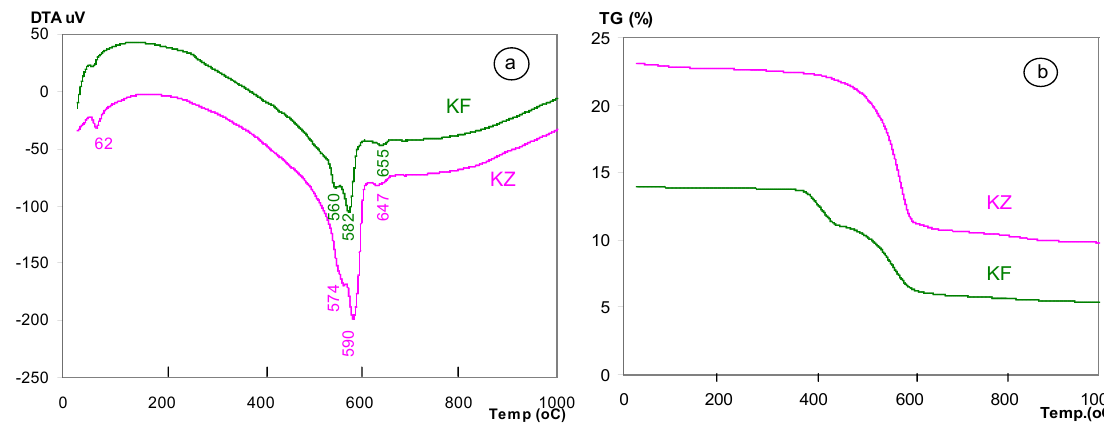
Figure 2. DTA (a) and TG (b) curves of dry gels (white powders) of KZ and KF.